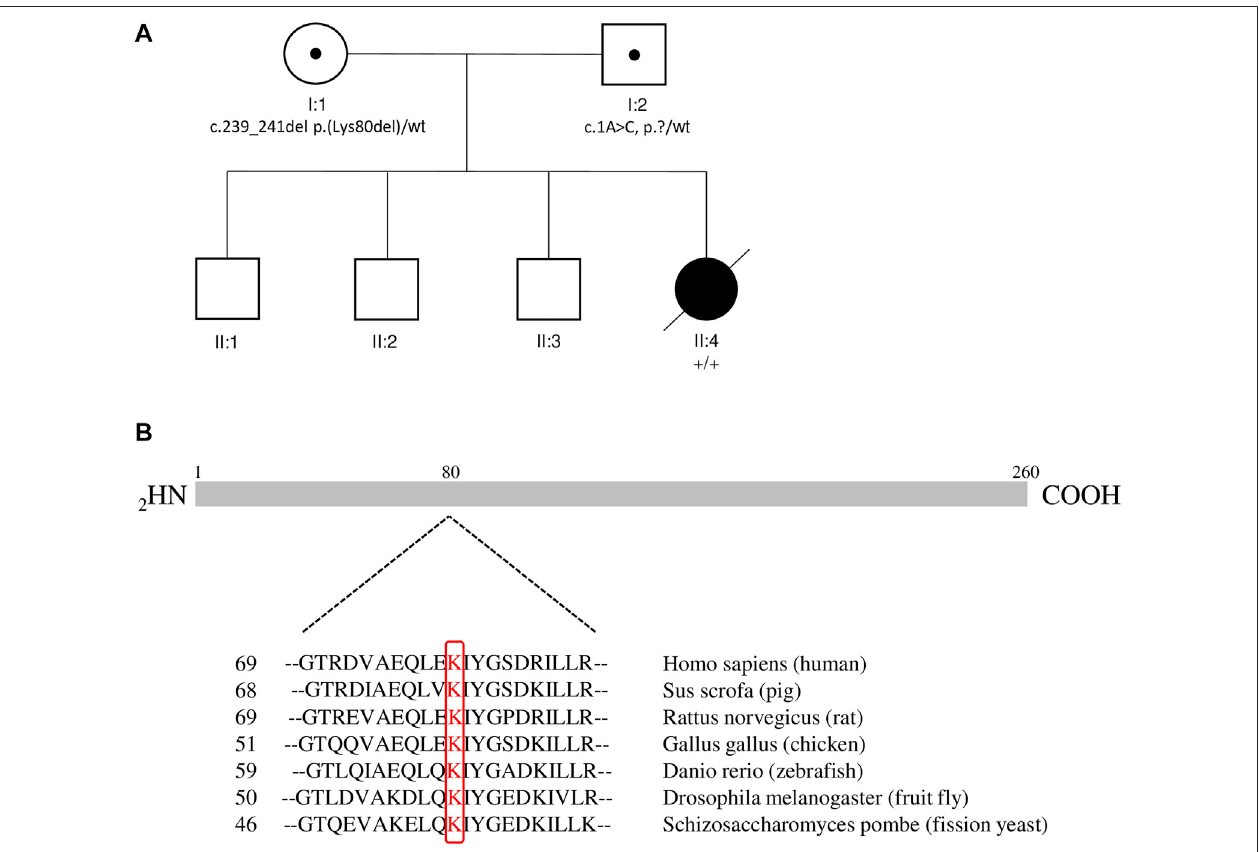
FIGURE 1 | Pedigree and Alignment of Amino Acid Conservation for DPM1. (A) The pedigree of the family. Black circle: affected female patient; open squares: unaffected males, open circle: unaffected female; black dots: carrier of the pathogenic variant. (B) Alignment of Amino Acid Conservation for DPM1 in Different Species. Sequences are the amino acids for indicated residues of the DPM1 protein in different species. Sequence positions in the respective species are shown on the left. Conserved lysins are highlighted in red. The primary structure of the human DPM1 protein is illustrated in cartoon form above the alignment.